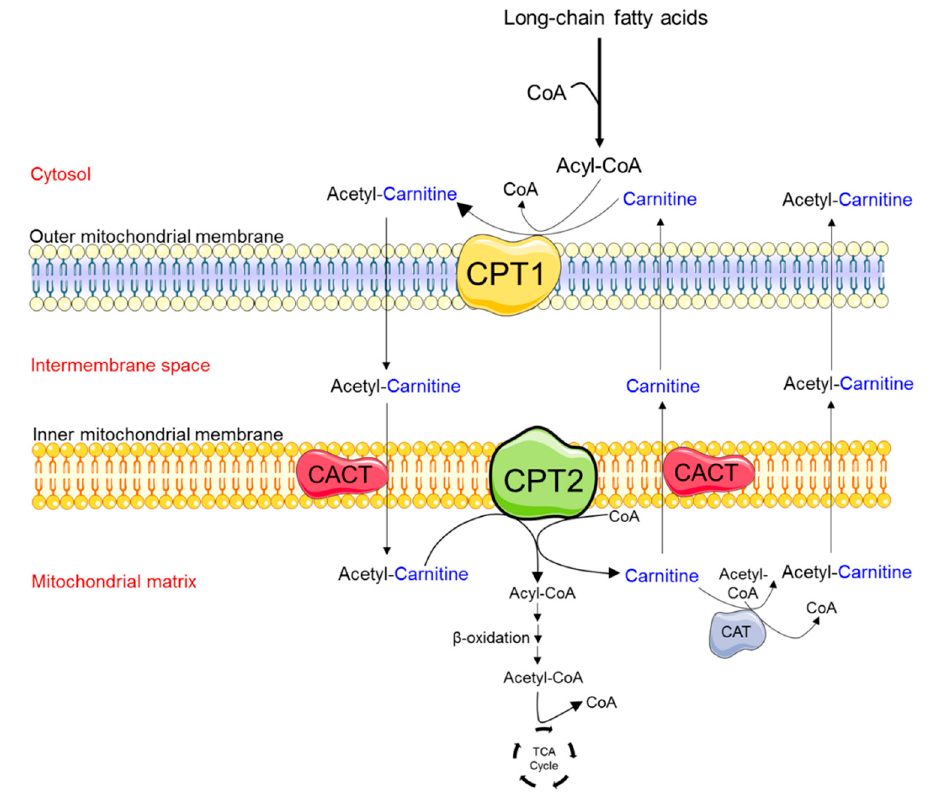
Figure 1. Schematic diagram depicting the enzymes involved in the transport of medium- and long-chain fatty acids into mitochondria. A key regulatory step in the process of fatty acid β -oxidation is the entrance of fatty acids into the mitochondria. This process is mediated by the carnitine-shuttle enzyme complex. Fatty acids that enter the cytosol are activated by the enzyme acyl-Coenzyme A (CoA) synthetase to produce long-chain fatty acid acyl-CoAs. Due to the lack of the acyl-CoA transporter in the mitochondrial inner membrane, the acyl group is transferred to the shuttle molecule, carnitine. In a rate-limiting step, carnitine palmitoyl transferase 1 (CPT1) catalyzes the conversion of long-chain acyl-CoAs into acylcarnitine at the mitochondrial outer membrane. Acylcarnitines cross the inner mitochondrial membrane via the carnitine acylcarnitine transporter (CACT). Carnitine palmitoyl transferase 2 (CPT2) is located on the matrix side of the inner mitochondrial membrane, where it transfers back the acyl groups from long-chain acylcarnitines to mitochondrial CoA, forming long-chain acyl-CoAs. Fatty acyl-CoA molecules then undergo the process of fatty acid β -oxidation, producing acetyl-CoA, which enters the tricarboxylic acid (TCA) cycle to produce energy (i.e., Adenosine Triphosphate, ATP). Carnitine can be removed from the mitochondrial matrix by CACT or the enzyme carnitine acetyltransferase (CAT) which can catalyze the transfer of short-chain fatty acids from CoA to carnitine.